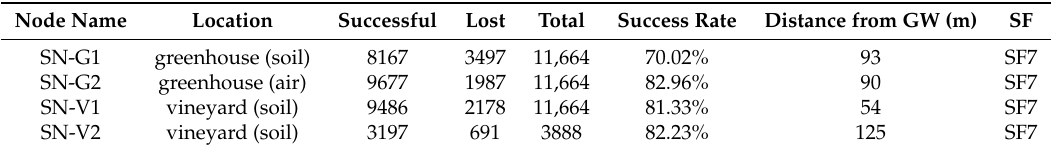
Table 5. Nodes deployed performance in terms of successful and lost observations during 81 days of